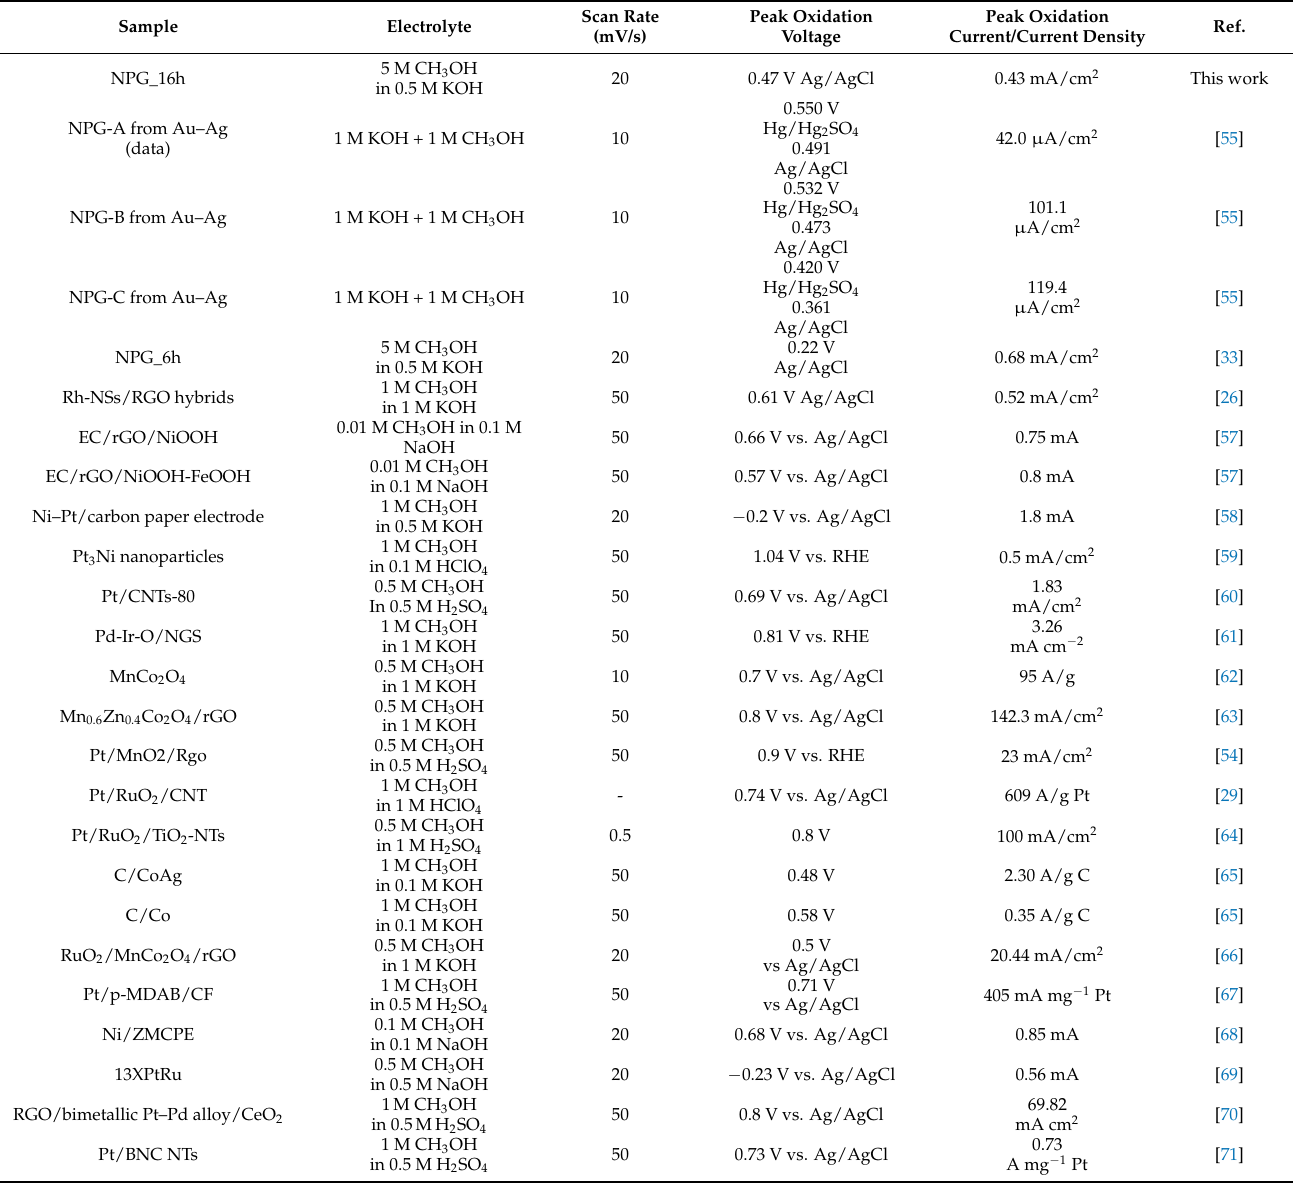
Table 1. Comparison of our work with the literature in terms of peak potentials of methanol oxidation and peak current/current